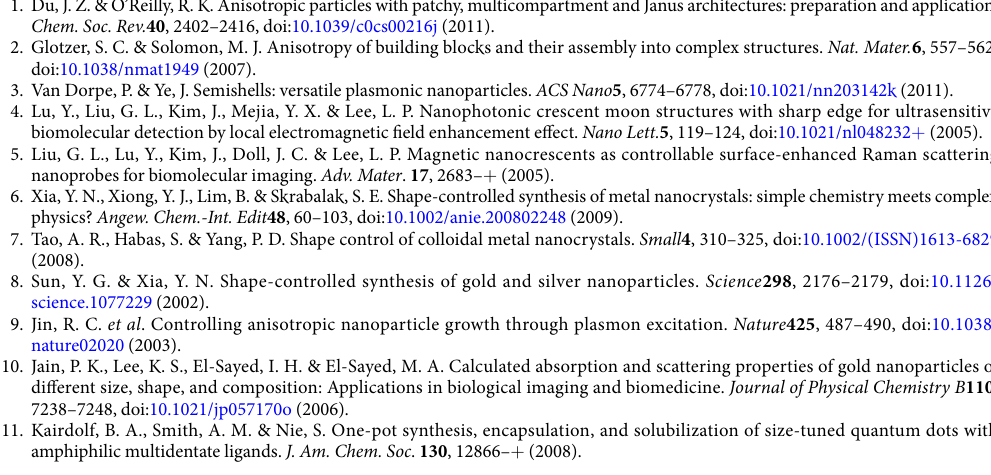
(320 rpm). The resulting mixture was stirred for 24 h at room temperature. The resulting silica NPs were centri- fuged and washed with ethanol three times. The size of the prepared NPs was ~120 nm, as shown in Supporting Fig. 1. These silica NPs were then thiol functionalized using 60 μ L of 3-mercaptopropyltrimethoxysilane (MPTS) and 100 uL of ammonium hydroxide, which were added to 5 mL of the dispersed silica NP solution (20 mg/mL in ethanol) and stirred for 12 h at room temperature. The thiol-functionalized silica NPs were centrifuged and washed with ethanol three times and with DMSO three times. Preparation of half-planar gold particles. First, the thiol-functionalized silica NPs were immobilized on the 2-CTC resin (Beadtech, Inc., Korea) using a standard peptide synthesis method. A 2 mL portion of the silica NP solution (50 mg/mL in DMSO) was added to 2 g of 2-CTC resin beads in reaction vessels. Then, 200 μ L of N , N -diisopropylethylamine (DIPEA) was added to the DMSO solution and shaken for 12 h at room temperature. A 40 μ L to 3 mL volume of gold source (1% w/w in DI water) was added to thiol-modified silica immobilized beads (50 mg) in water under vigorous magnetic stirring. Then, 500 μ L of hydroxylamine (0.5 mg/mL in water) was added. After the reaction (typically overnight), the remaining reagents were washed with water and ethanol, and the reaction vessel was filled with 10 mL of ethanol. Then, the surface of the gold particles on the beads in solution was coated with mercaptocarboxylic acid, which contains a thiol group, so that a negative surface charge is produced to prevent aggregation. This was accomplished by first washing with ethanol, then with methylene chloride, and adding 100 μ L of mercaptocarboxylic acid to the beads and shaking for 1 h. Finally, the particles were cleaved from the beads in a mildly acidic environment with 2 mL TFA for 1 h. The solution was collected by filtration (impurities from the 2-CTC resin could also be detached from beads. However, they were removed in our experiments). The particles were obtained by centrifugation 18–22 .